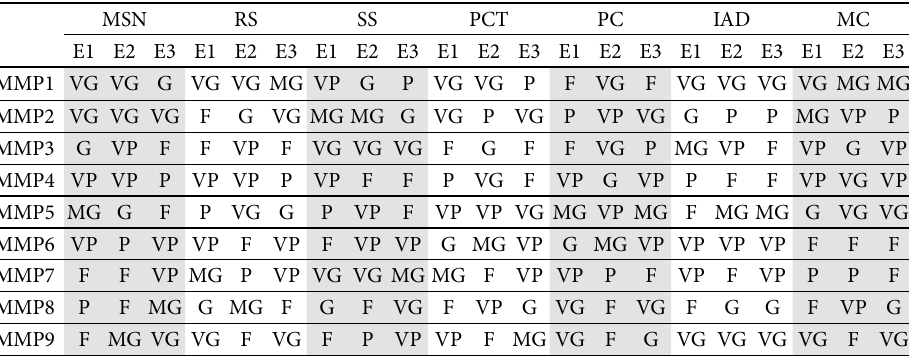
Table 8. The rating of alternatives MSN RS SS PCT PC IAD